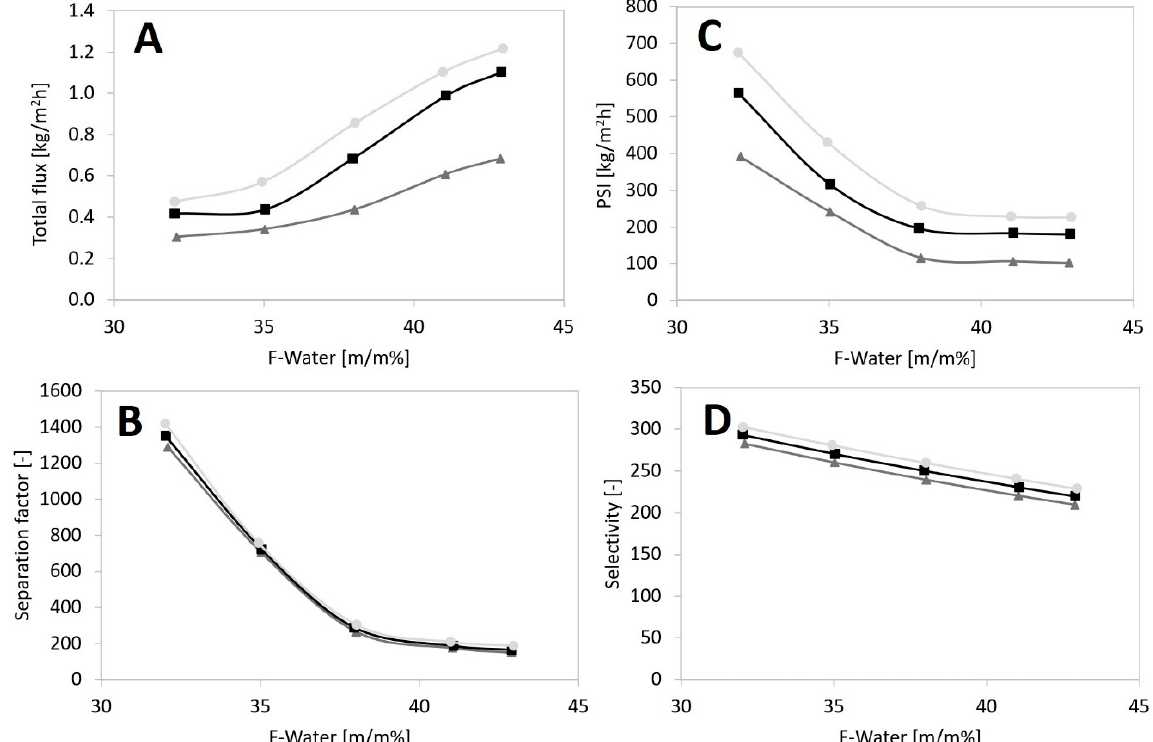
Figure 4. Separation achievement as a function of feed content at different operating temperatures for PERVAP™ 1201 membrane (70 °C: ; 80 °C: ; 90 °C: ), ( A ) Total flux, ( B ) Separation factor, ( C ) PSI, ( D ) Selectivity.